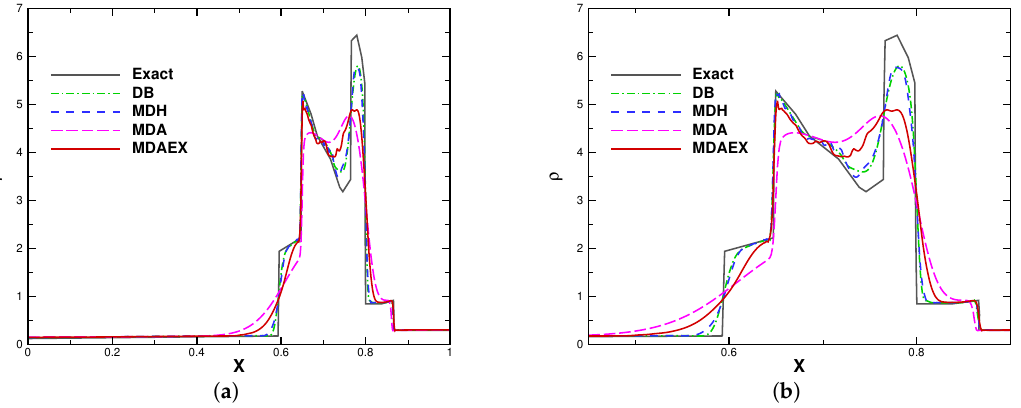
Figure 14. Density solution for the blast wave problem with 300 elements at t = 0.038, P 2. ( a ) Overview; ( b ) zoomed in results.